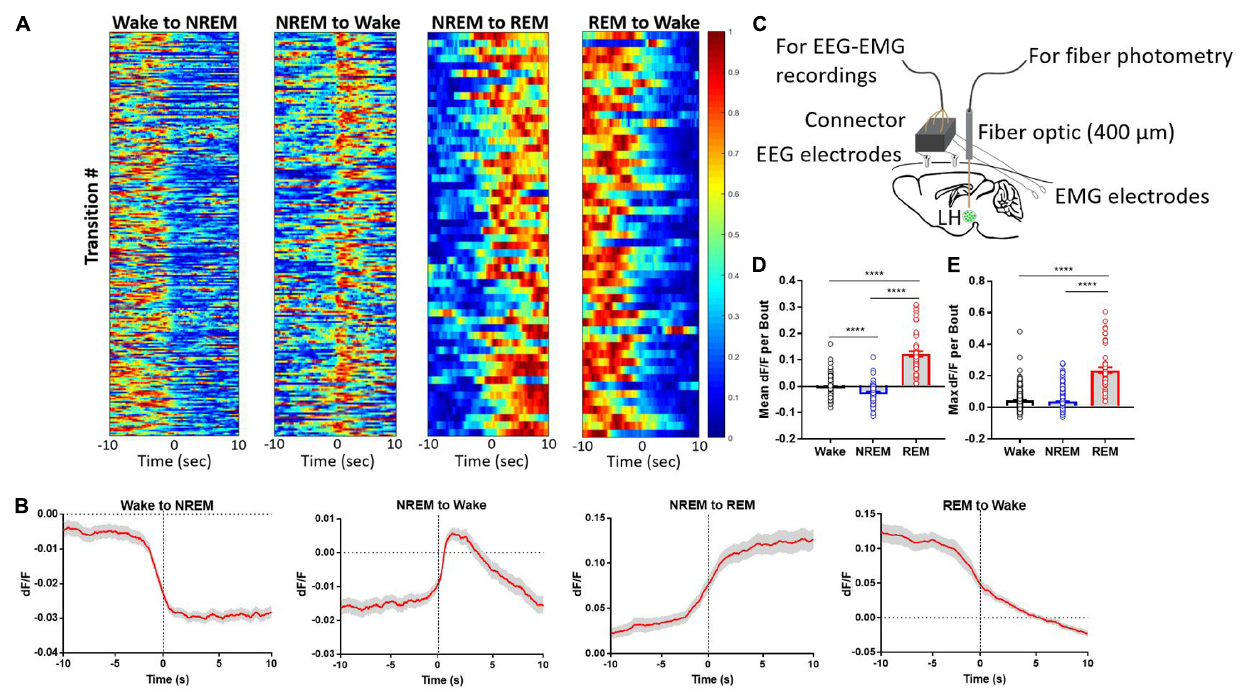
FIGURE 1 | Lateral hypothalamic GABAergic neurons are wake- and REM sleep-active. (A) Heatmaps showing GCaMP6s signal across arousal state transitions (Wake-to-NREM (256 transitions), NREM-to-Wake ( n = 208 transitions), NREM-to-REM ( n = 60 transitions), and REM-to-Wake ( n = 57 transitions), with transition number on the y-axis and time on the x-axis; GCaMP6s signal is reflected in the colormap. (B) The same data as in panel (A) but collapsed into the average signal time series across arousal state transitions. (C) Experimental design describing the set up for simultaneous recording of EEG/EMG + fiber photometry signal from freely moving mice. (D) mean dF/F of LH GABA neuronal activity per bout of each arousal state (One-way ANOVA F 2 , 591 = 438.1; p < 0.0001); (Tukey’s post hoc wake vs. NREM: q = 10.72, adjusted p < 0.0001; wake vs. REM: q = 35.58, adjusted p < 0.0001; NREM vs. REM: q = 41.84, adjusted p < 0.0001). (E) max dF/F of LH GABA neuronal activity per bout of each arousal state (One-way ANOVA F 2 , 591 = 212.9; p < 0.0001); (Tukey’s post hoc wake vs. REM: q = 27.29, adjusted p < 0.0001; NREM vs. REM: q = 28.45, p < 0.0001). Error bars represent S.E.M., N = 5 mice, **** p < 0.0001, One-way ANOVA followed by Tukey’s HSD post hoc